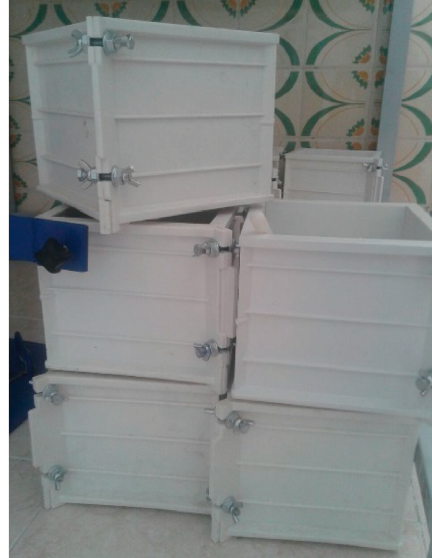
Figure 5: The used plastic. The plastic was chosen for better quality of samples and to avoid sticking.